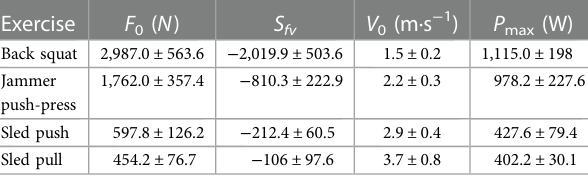
TABLE 2 Team force-velocity